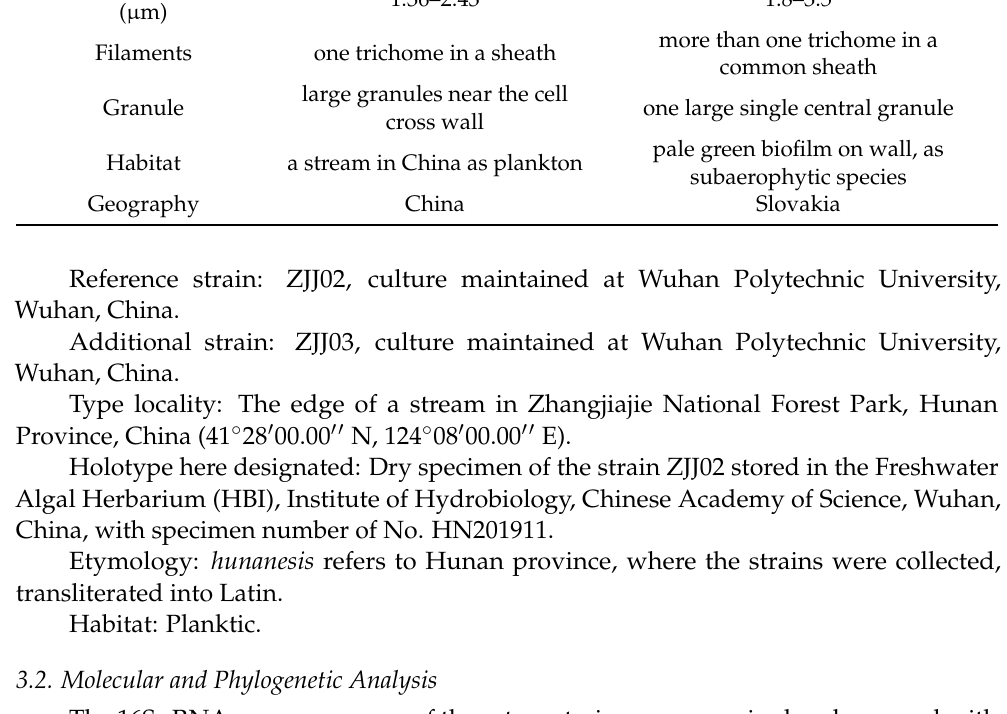
Table 2. Comparison of the characteristics of Cartusia hunanesis and Cartusia fontana.